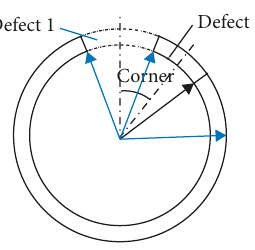
Figure 16: Schematic diagram of the model.